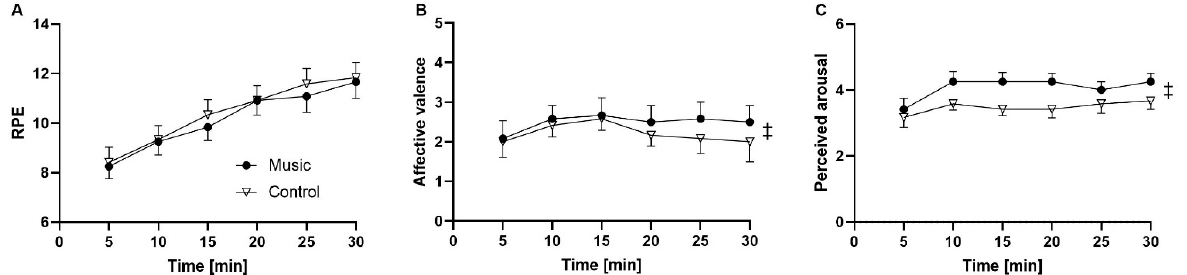
Figure 8. Time course of rating of perceived exertion ( A ), affective valence ( B ), and perceived arousal ( C ) for the music condition (filled circles) and the control condition (open triangles). ‡ main effect of condition ( p < 0.05).